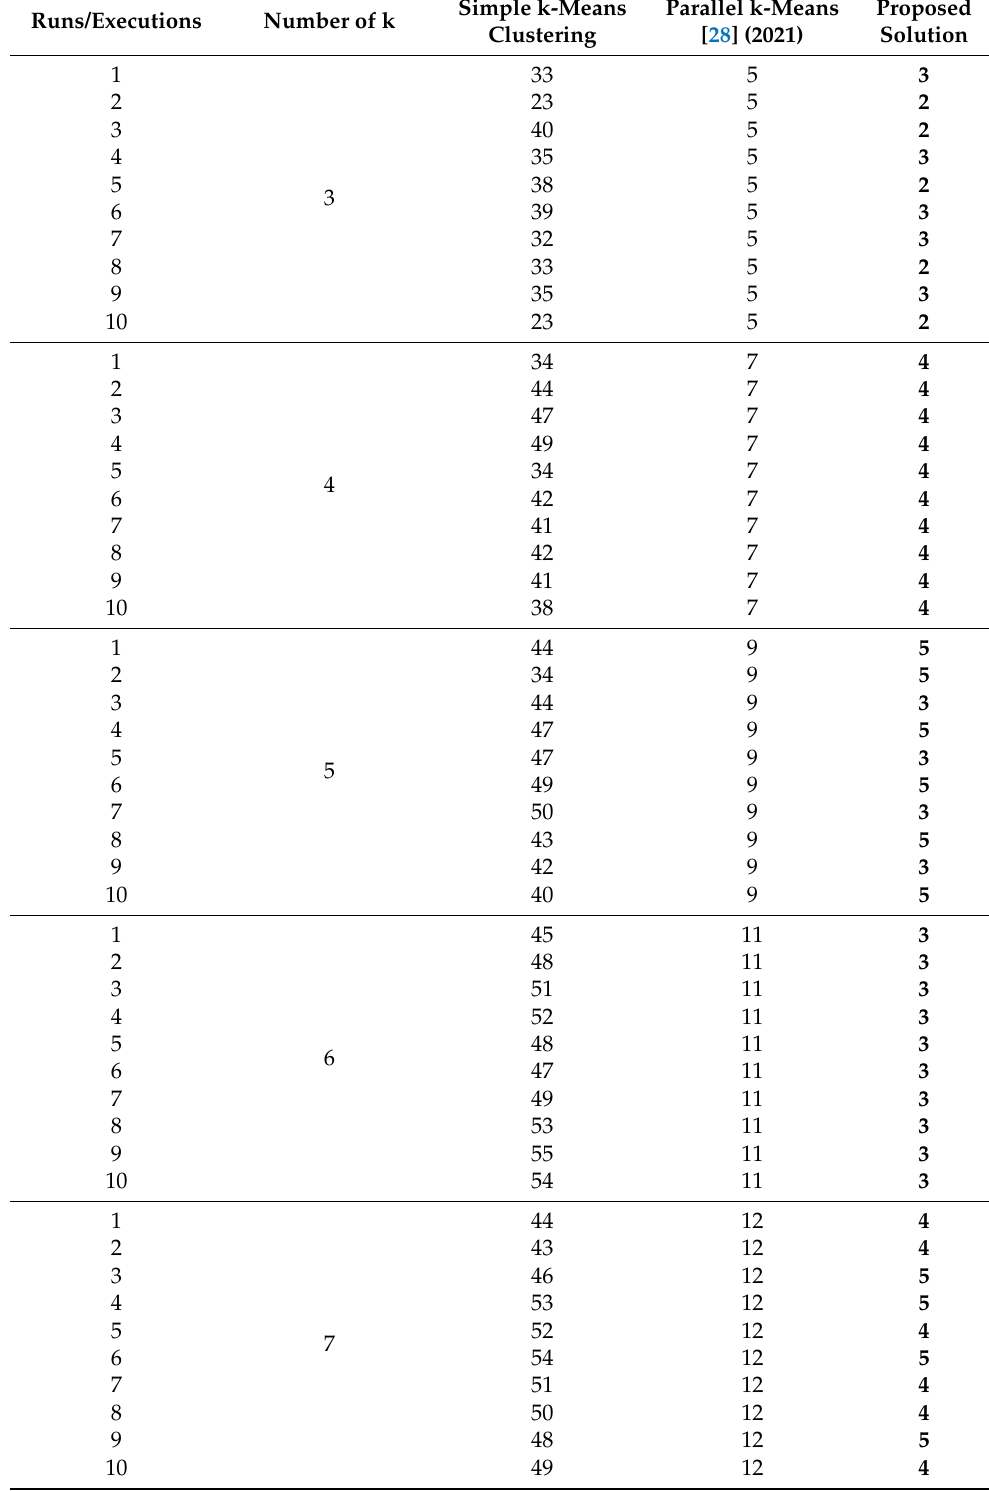
Table 6. Number of iterations for k